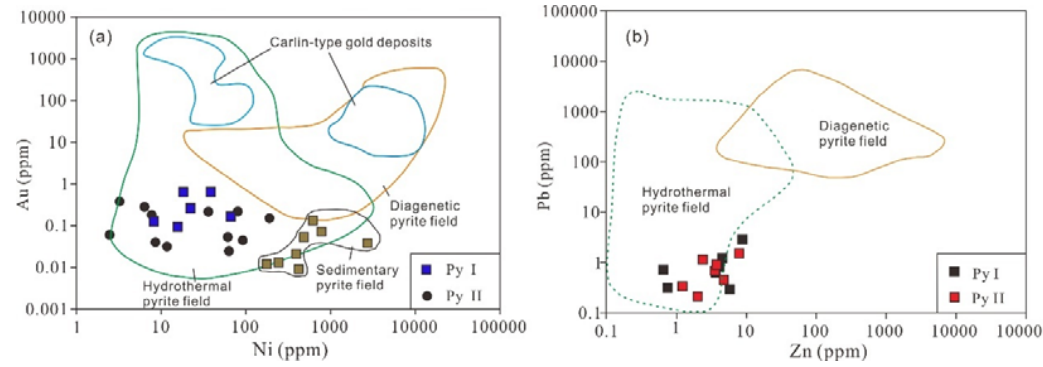
Figure 8. Ni vs. Au diagram ( a ) and Zn vs. Pb diagram ( b ) for pyrite from massive and lamellar ores of the Dongguashan copper (gold) deposit (after Reference [6]). Data of sedimentary pyrite are from Reference [54].